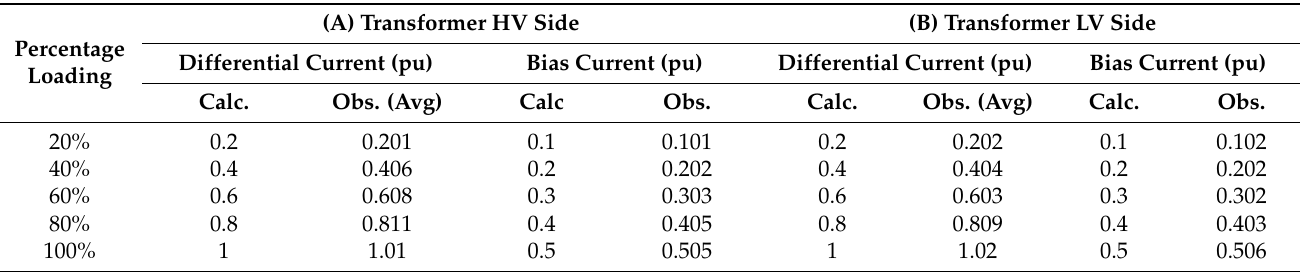
Table 6. Differential and bias current measured by relay for different percentage loading of: ( A ) transformer HV side and ( B ) transformer LV